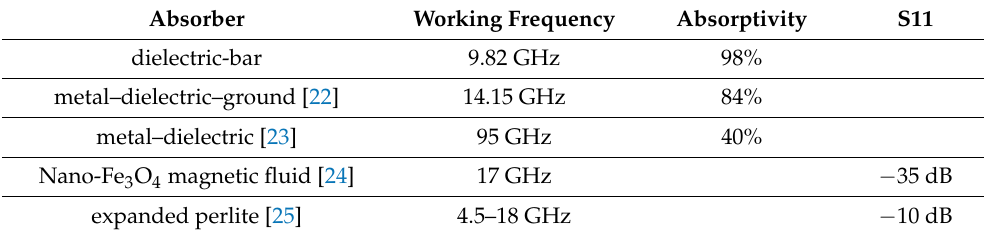
Table 2. A comparison between the proposed work and existing